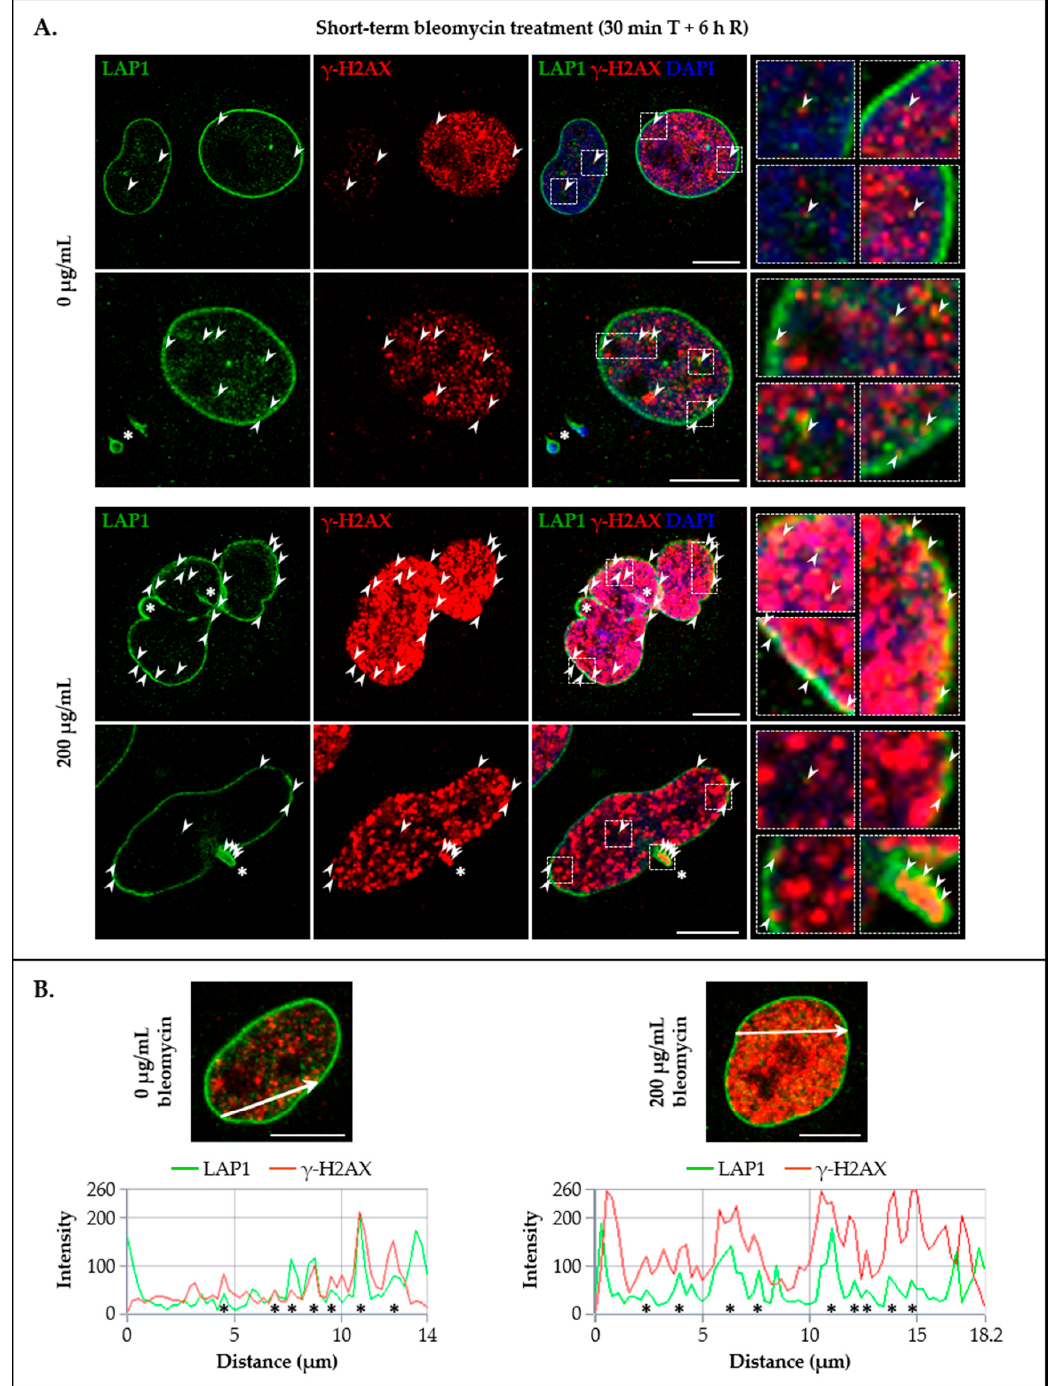
Figure 6. Analysis of the subcellular co-distribution of LAP1 and γ -H2AX in the human HeLa cell line. ( A ) Immunolocalization of LAP1 (green) and γ -H2AX (red) in control conditions and after DNA damage induction through cell exposure to 200 µg/mL of bleomycin for 30 min (T), followed by 6 h of recovery (R). Upon fixation, HeLa cells were immunostained with LAP1- and γ -H2AX-specific primary antibodies linked to AF 488- and AF 594-conjugated secondary antibodies, respectively, and incubated with mounting medium containing DAPI (blue). Image acquisition was performed using an LSM 880 confocal laser scanning microscope with Airyscan. Representative microphotographs (one section in the Z-axis) are shown for each experimental condition. The presence of nuclear LAP1/ γ -H2AX co-localization sites are identified by arrowheads and highlighted in the ROIs of merged images